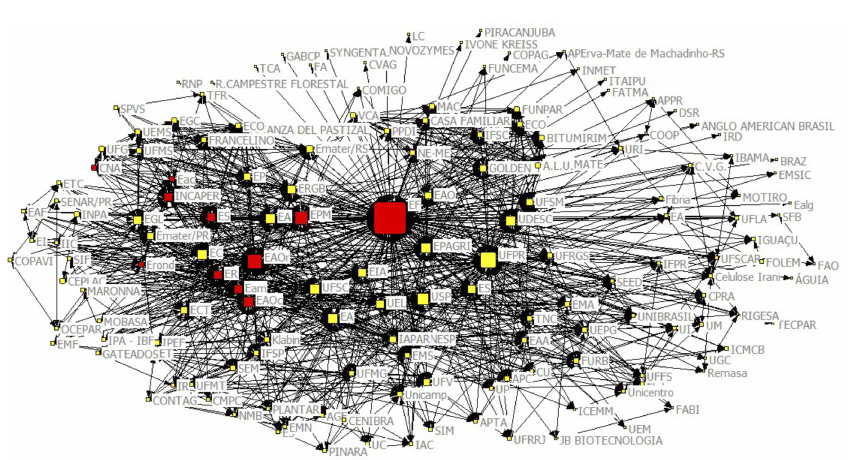
Figure 2. Embrapa Florestas closed innovation network